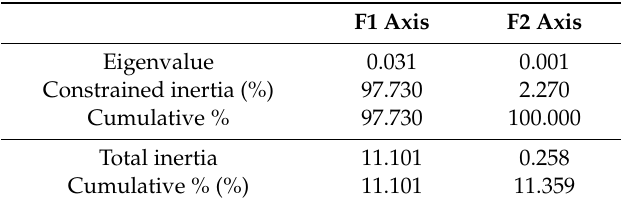
Table 2. Eigenvalues and percentages of inertia (redundancy analysis).